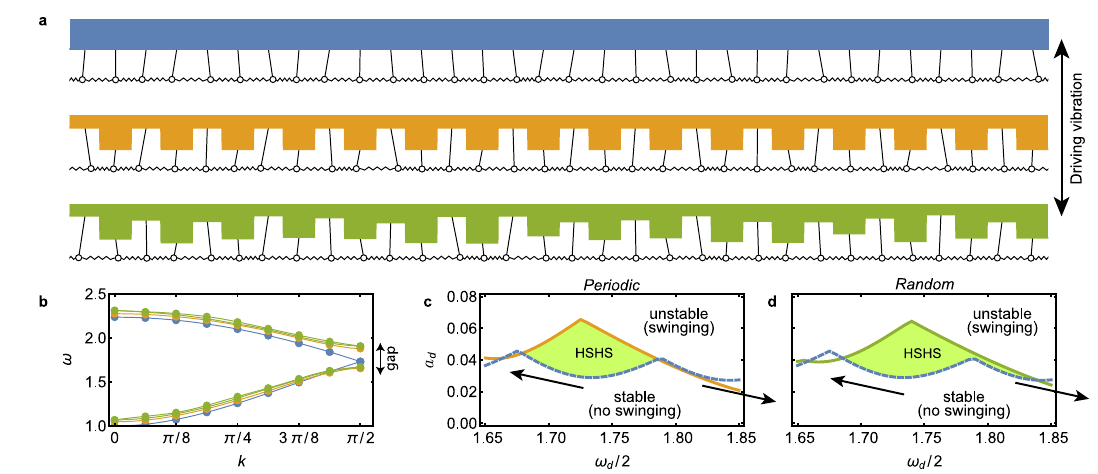
Fig. 2 Heterogeneity-stabilized homogeneous states in arrays of coupled pendula. a Arrays of coupled pendula with homogeneous support (top), periodic support (middle), and random support (bottom). b Angular frequency ω vs. wavenumber k in the dispersion relation, where the color- corresponding dots show modes for the respective arrays in a and the lines serve as a guide to the eye suggestive of the in fi nite-pendulum limit. The heterogeneities open a band gap at k = π /2 around ω = 1.75. c , d Instability boundaries in the driving amplitude a d vs. driving frequency ω d space for the periodic support ( c ) and the random support ( d ), with swinging wave motion emerging above the solid lines and with the dashed lines marking this boundary in the homogeneous case. The arrows in c , d indicate how instability tongues move in response to the band gap opening, leading to HSHS in the shaded areas. Animations of the pendulum arrays in a are available in Supplementary Movie